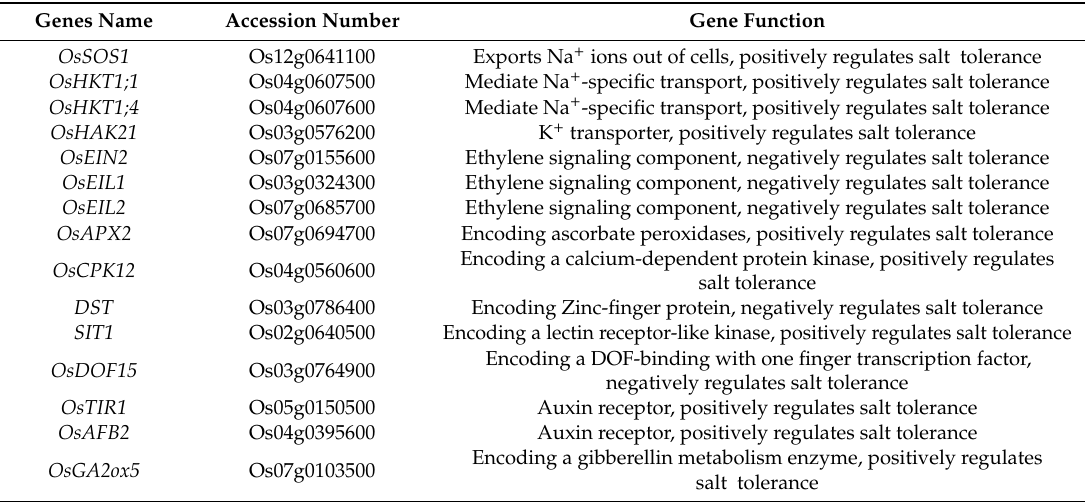
Table 3. Genes associated with rice salt